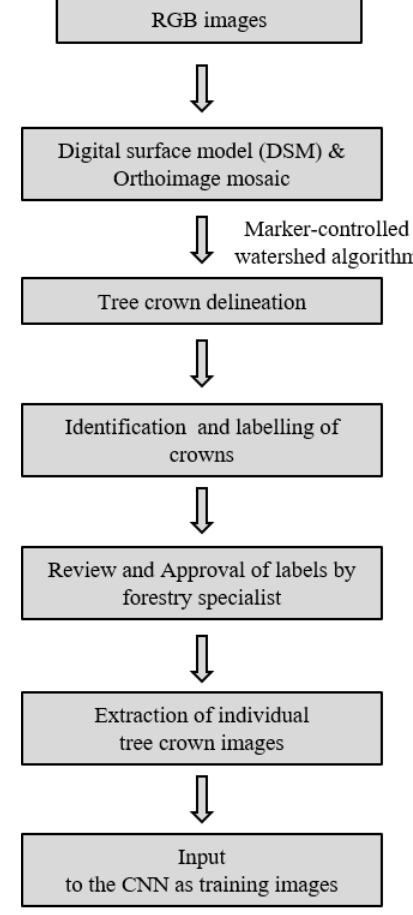
Figure 5. Workflow for preparation of training data